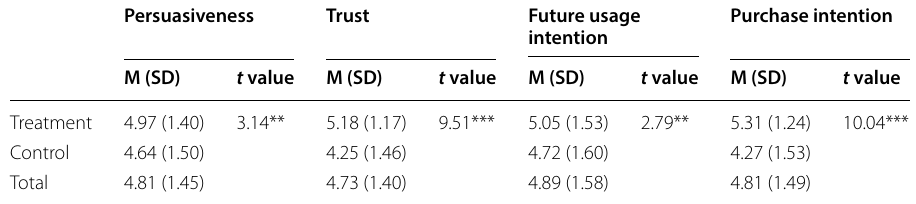
Treatment group n